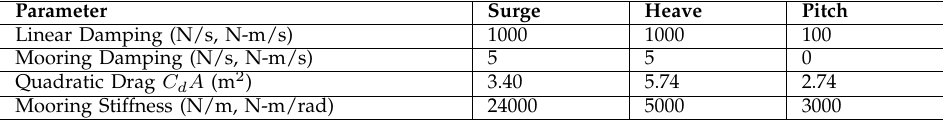
TABLE I: WEC-Sim parameters for system identification and control simulations Parameter